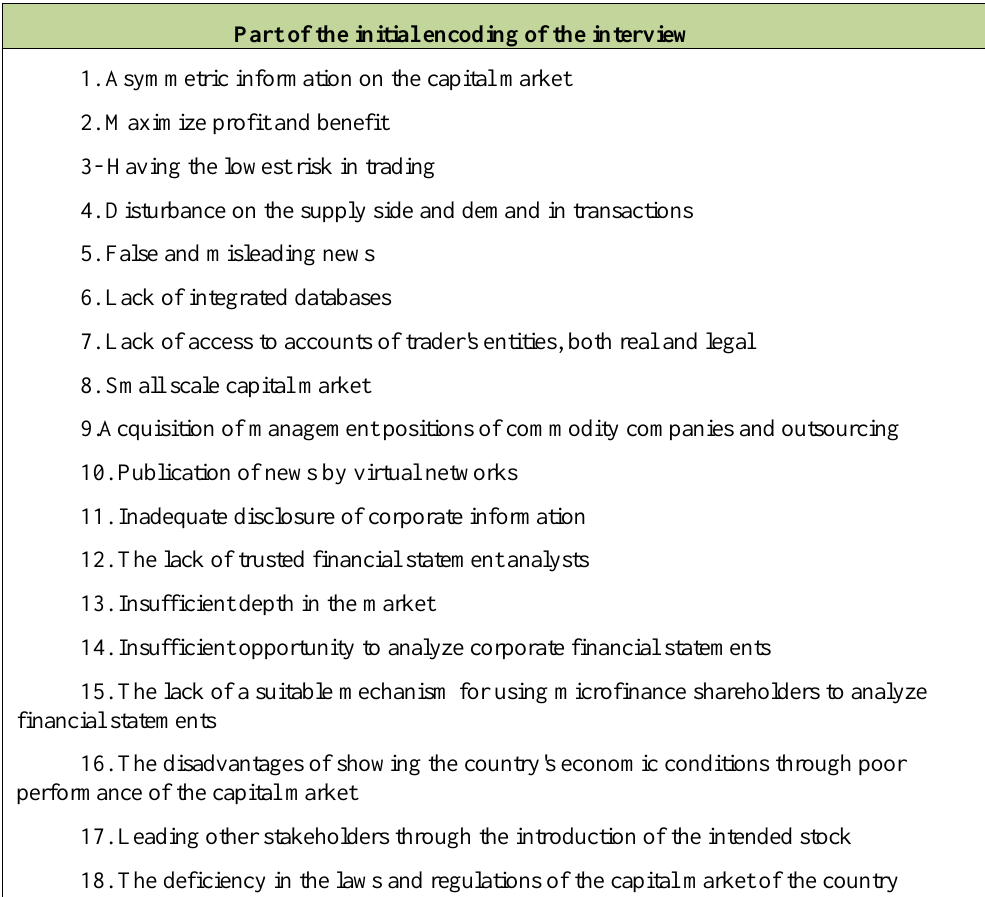
Table 2. an example of initial coding of